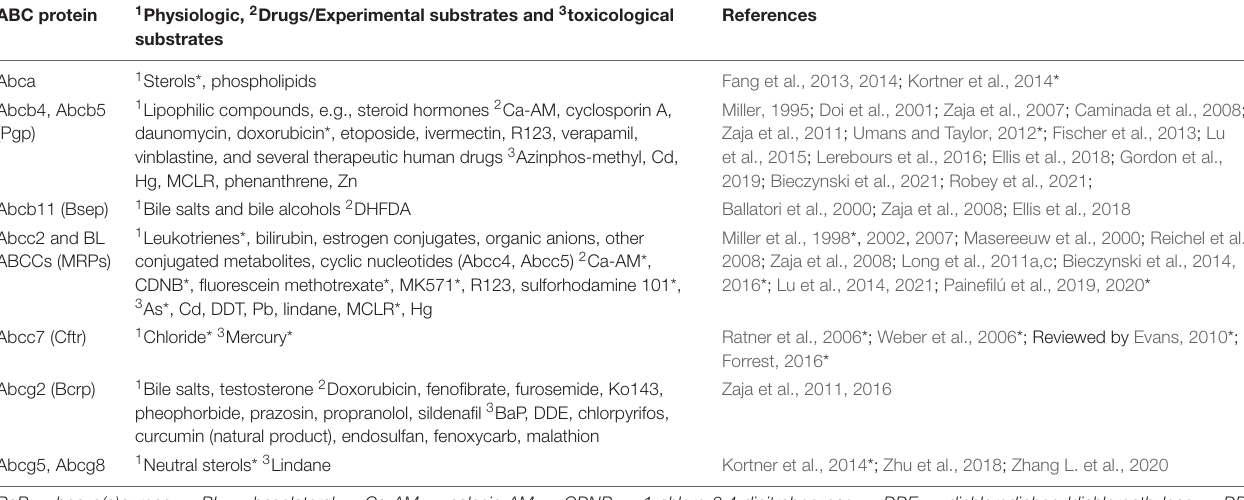
TABLE 3 | Representative chemical compounds, which interact with fish ABC proteins presented in alphabetical